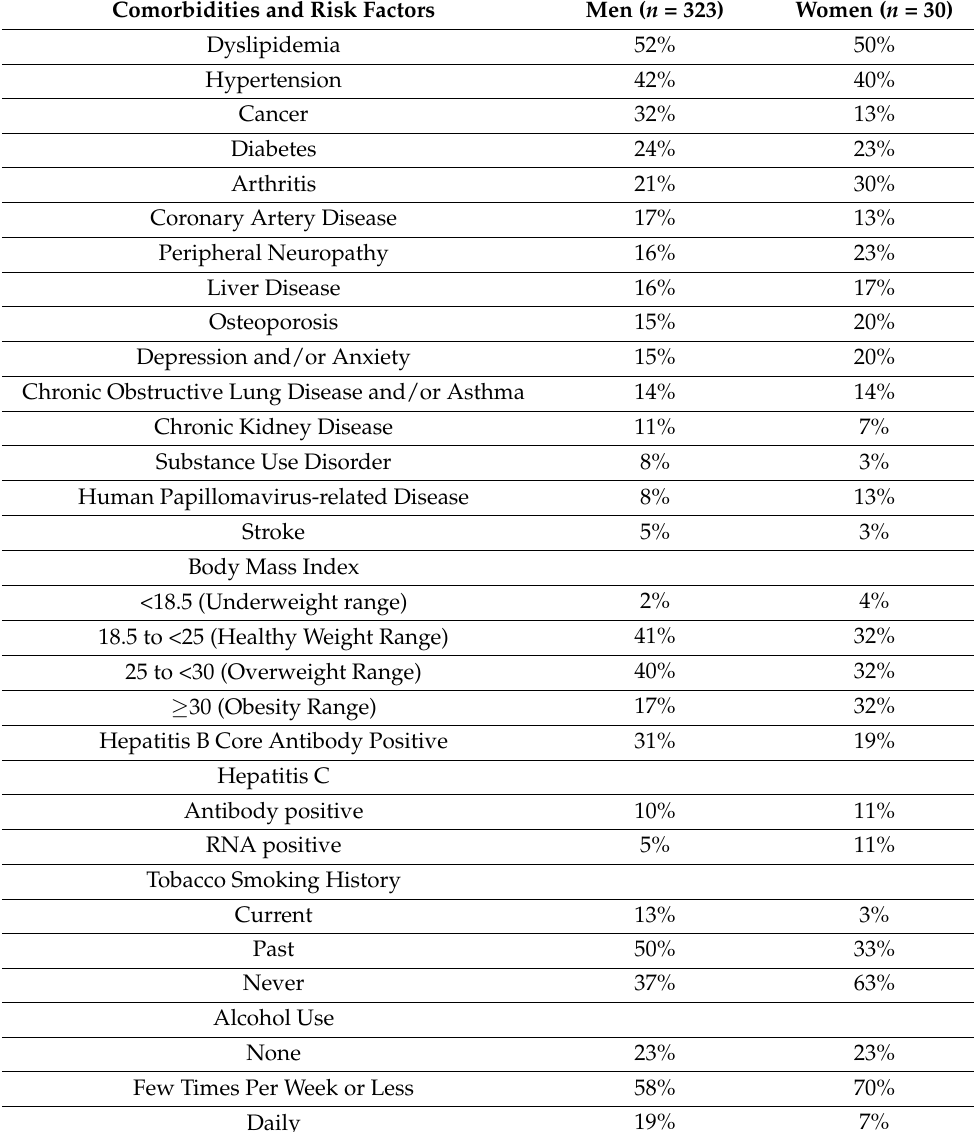
Table 2. Medical comorbidities and risk factors among participants enrolled in the CHANGE HIV cohort, according to